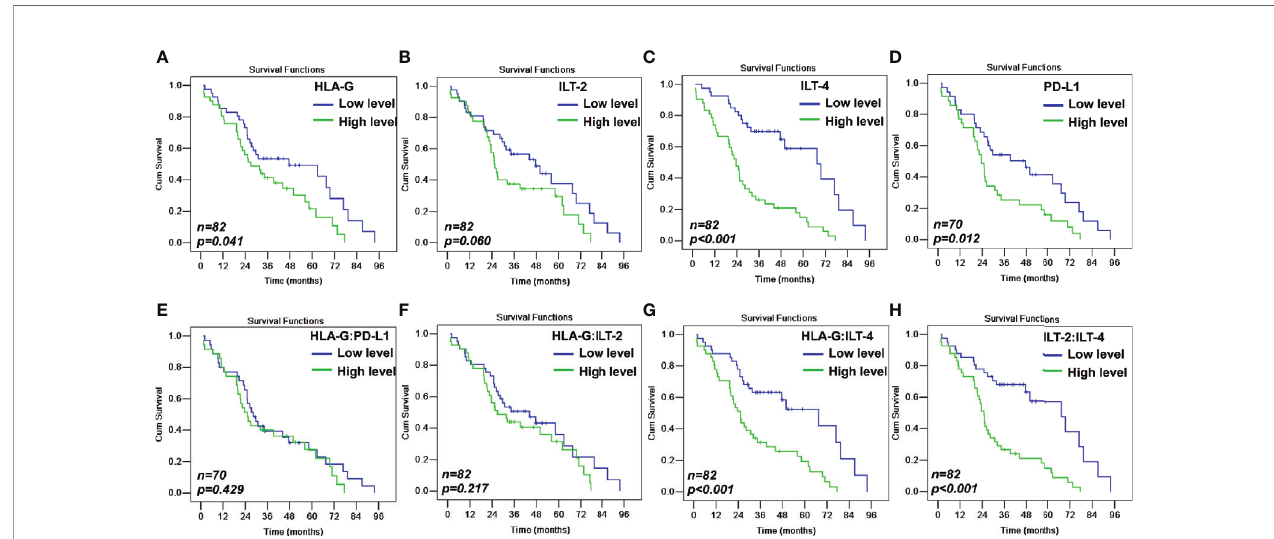
FIGURE 3 | Kaplan-Meier survival analysis for patients with CRC between (A) HLA-G high and HLA-G low ( p =0.041); (B) ILT-2 high and ILT-2 low ( p =0.060); (C) ILT-4 high and ILT-4 low ( p <0.001); (D) PD-L1 high and PD-L1 low ( p =0.012); (E) HLA-G:PD-L1 high and HLA-G:PD-L1 low ( p =0.429); (F) HLA-G:ILT-2 high and HLA-GILT-2 low ( p =0.217); (G) HLA-GILT-4 high and HLA-G:ILT-4 low ( p <0.001); and (H) ILT-2:ILT-4 high and ILT-2ILT-4 low ( p <0.001).